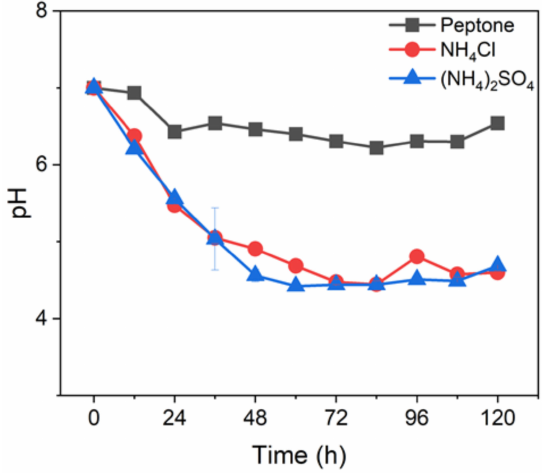
Figure 4. Different nitrogen sources affect the change of